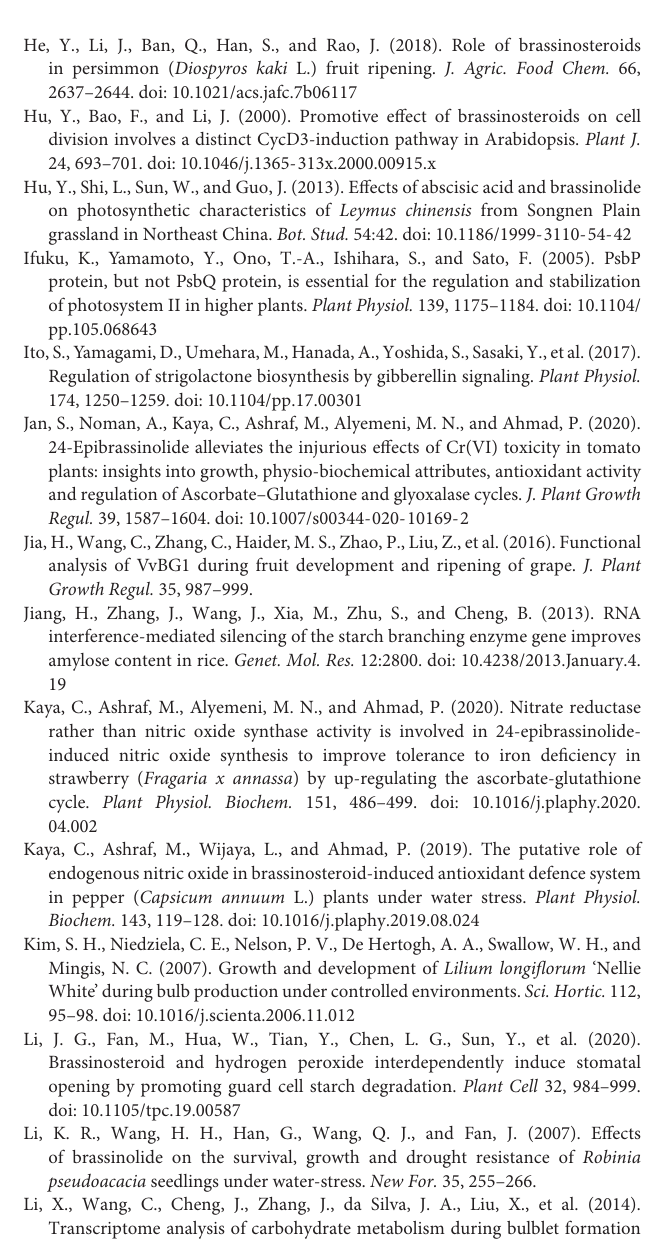
Pcz, and BR vs. Pcz groups. Supplementary Figure 2 | Cluster analysis of DEGs under control, BR, and Pcz treatments. Supplementary Figure 3 | Comparison of the expression patterns of genes involved in the starch and sucrose metabolism, photosynthesis pathway, and hormone signaling pathway in bulbil of P. ternata under control, BR, and Pcz treatments by qRT-PCR and RNA-seq. values are means of three replicates ± SE. Supplementary Figure 4 | Correlation plot between RNA-seq and qRT-PCR for the relative expression of unigenes. Supplementary Table 1 | Primers used for quantitative real-time PCR. Supplementary Table 2 | Length distribution of assembled